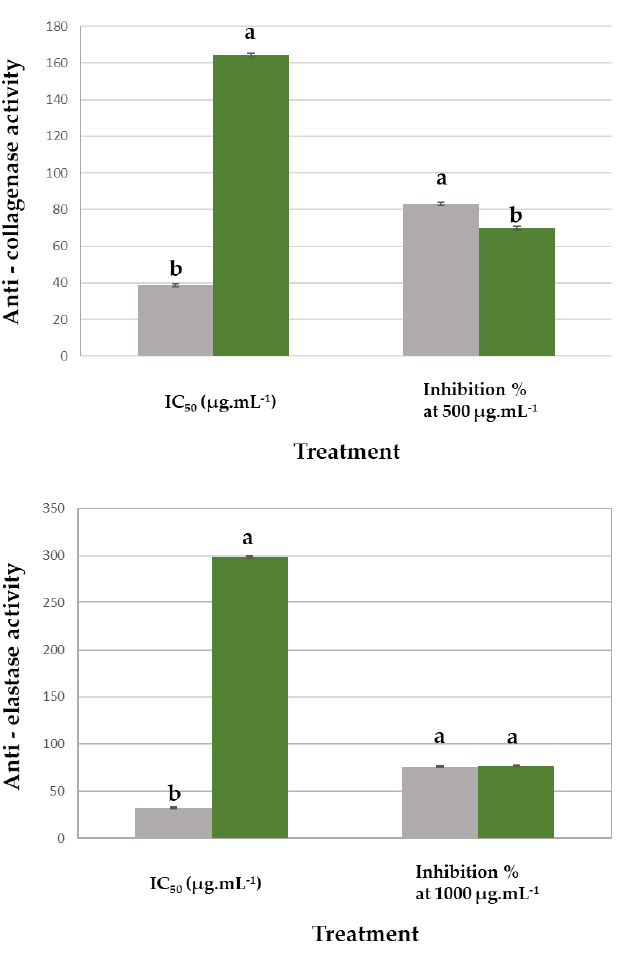
Figure 1. Collagenase and Elastase inhibition represented by anti-collagenase activity and anti-elastase activity of the EO of Citrus aurantium leaves. Means and standard deviation values are displayed. Grey columns represent control and green ones essential oil Similar letters for the same treatment indicate non-significant differences as indicated by Duncan’s multiple range test, at p < 0.01.